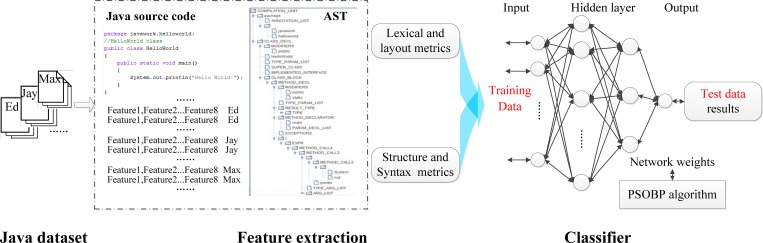
Framework overview.